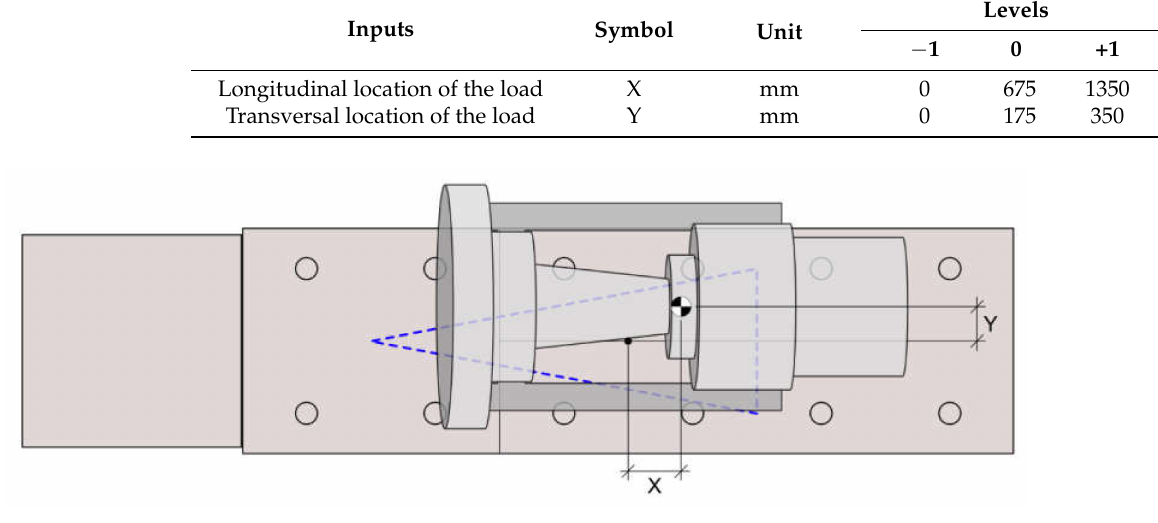
Figure 8. Nacelle wind turbine on the 6-axle